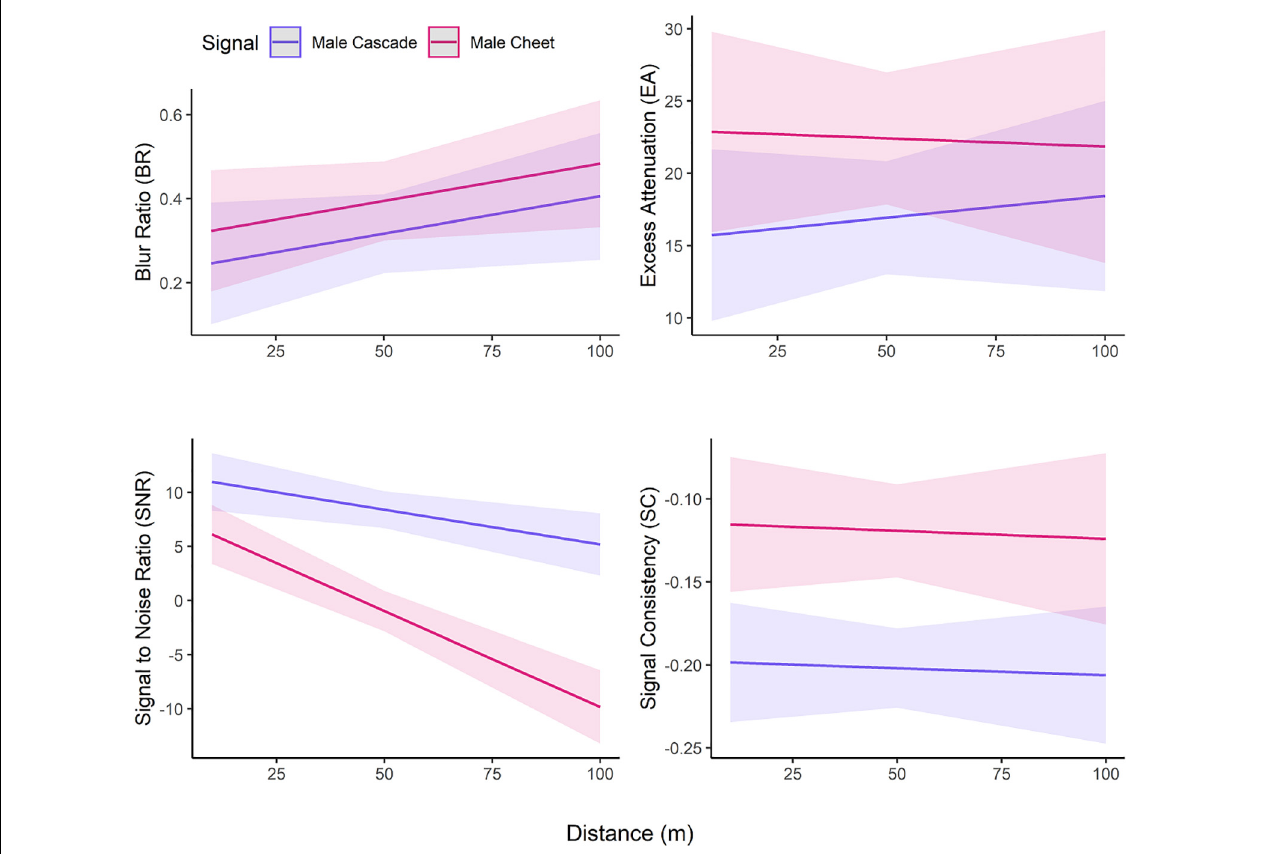
FIGURE 3 | Modeled metrics of propagation quality and consistency for male canyon wren song cascades and “cheet” notes. Model includes 20 songs, with sex, distance, and song identity as fixed